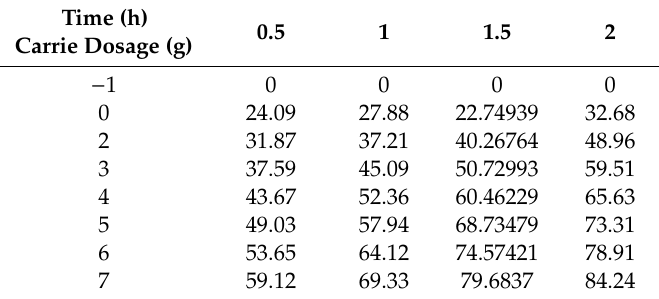
Table 3. Removal rate of MB under di ff erent dosage.